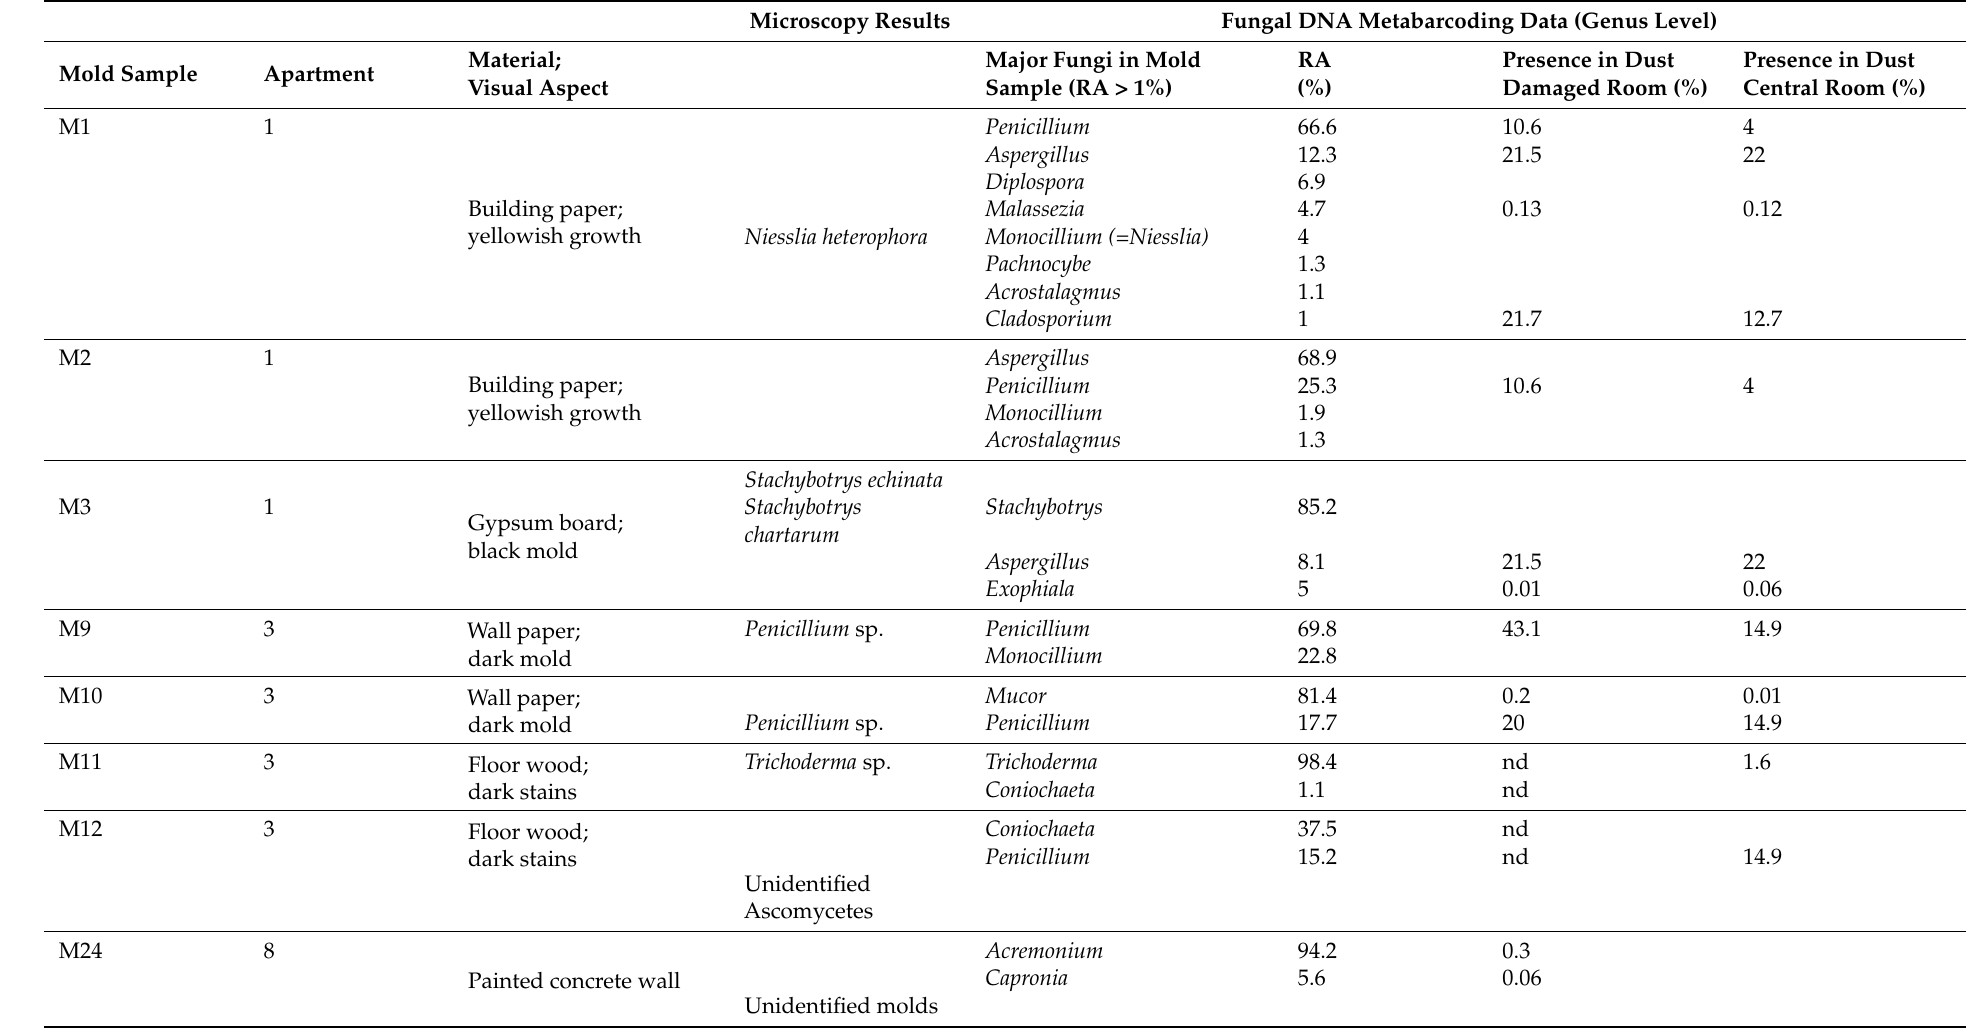
Table 2. Comparison of fungi detected by microscopy (mold samples) and DNA metabarcoding (both mold and dust samples) in different substrates. Data from eleven apartments that include dust samples from two different rooms (damaged and